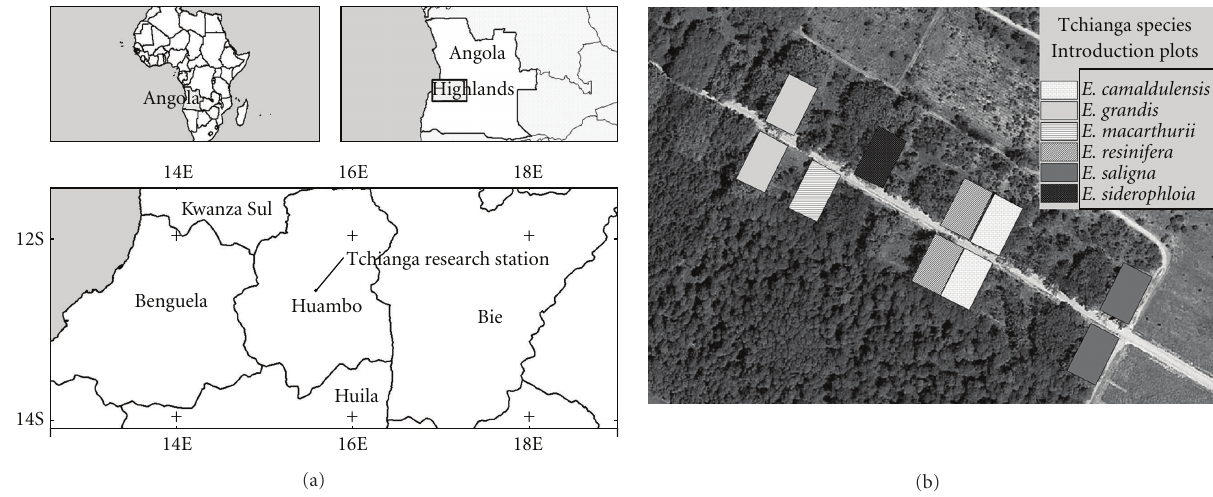
Figure 1: Location of the Tchianga species introduction experiment in the Central Angolan Highlands. The analysed sample plots of the six Eucalyptus species are shown (image obtained from Google Earth).